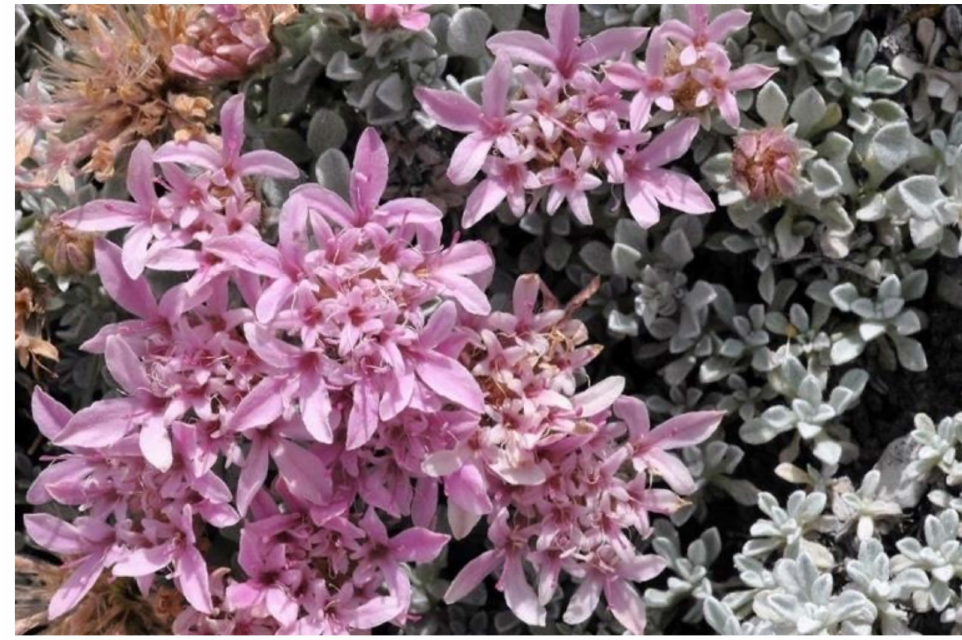
Figure 2. General appearance of the inflorescences and leaves of P. spathulatus (Photo by J.